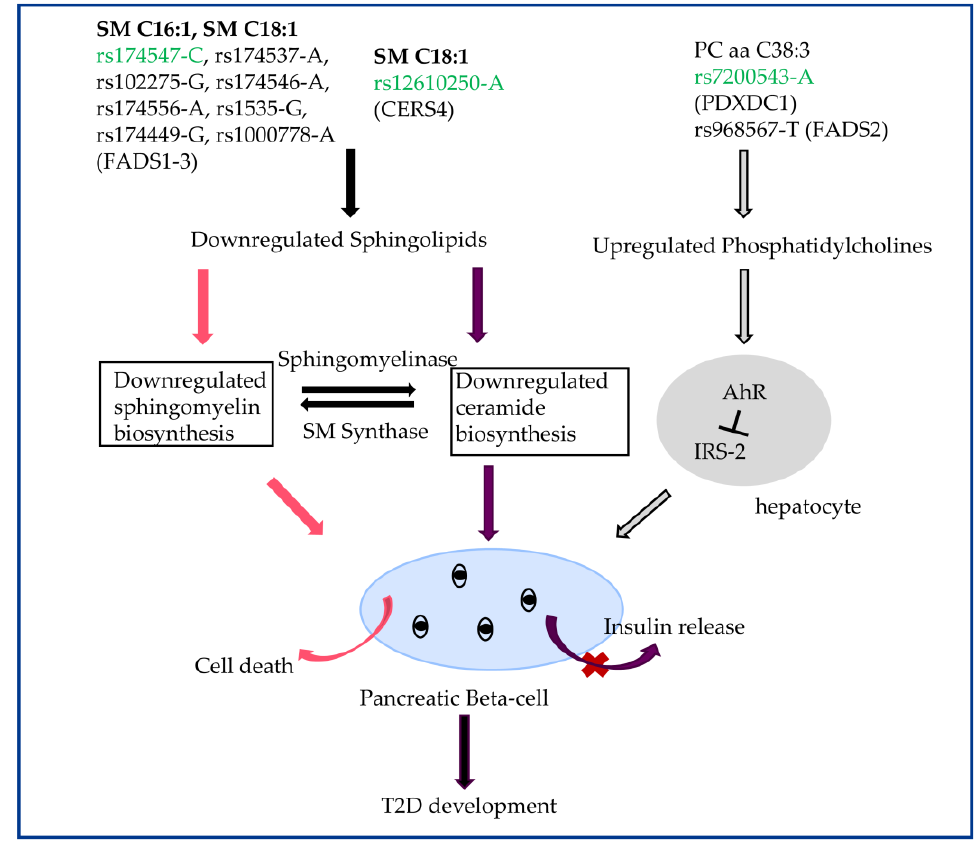
Figure 7. Schematic representation of the pathway analysis of diminished sphingolipid metabolism to a transition of T2D. The SNPs marked with green are the ones used in the MR test. The red pathway is generally involved in sphingomyelins (SM), the purple and gray pathways are for ceramides, and phosphatidylcholines (PC), respectively. All three kinds of metabolites influence insulin